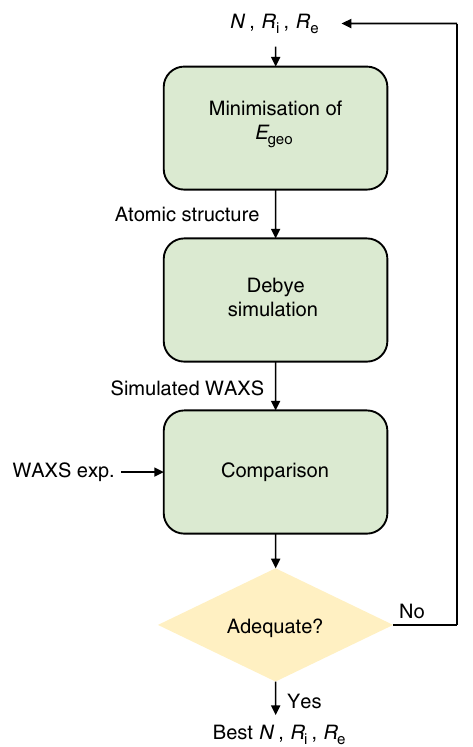
Fig. 4 Flowchart illustrating WAXS fi tting method